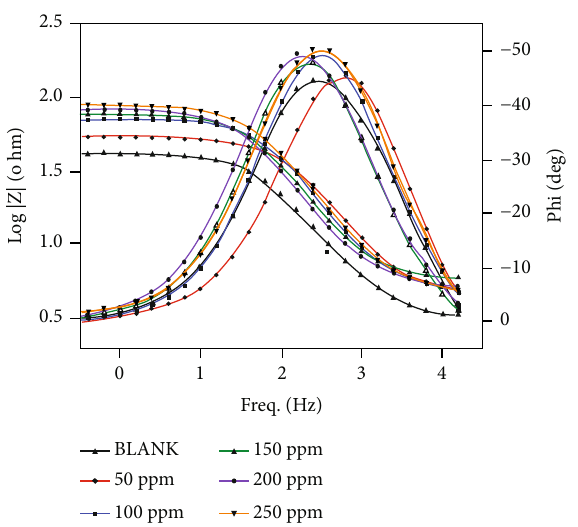
Figure 4: Bode plot for MS obtained with the absence and presence of 50-250 ppm of 3-nitroacetophenone in 1N HCl.